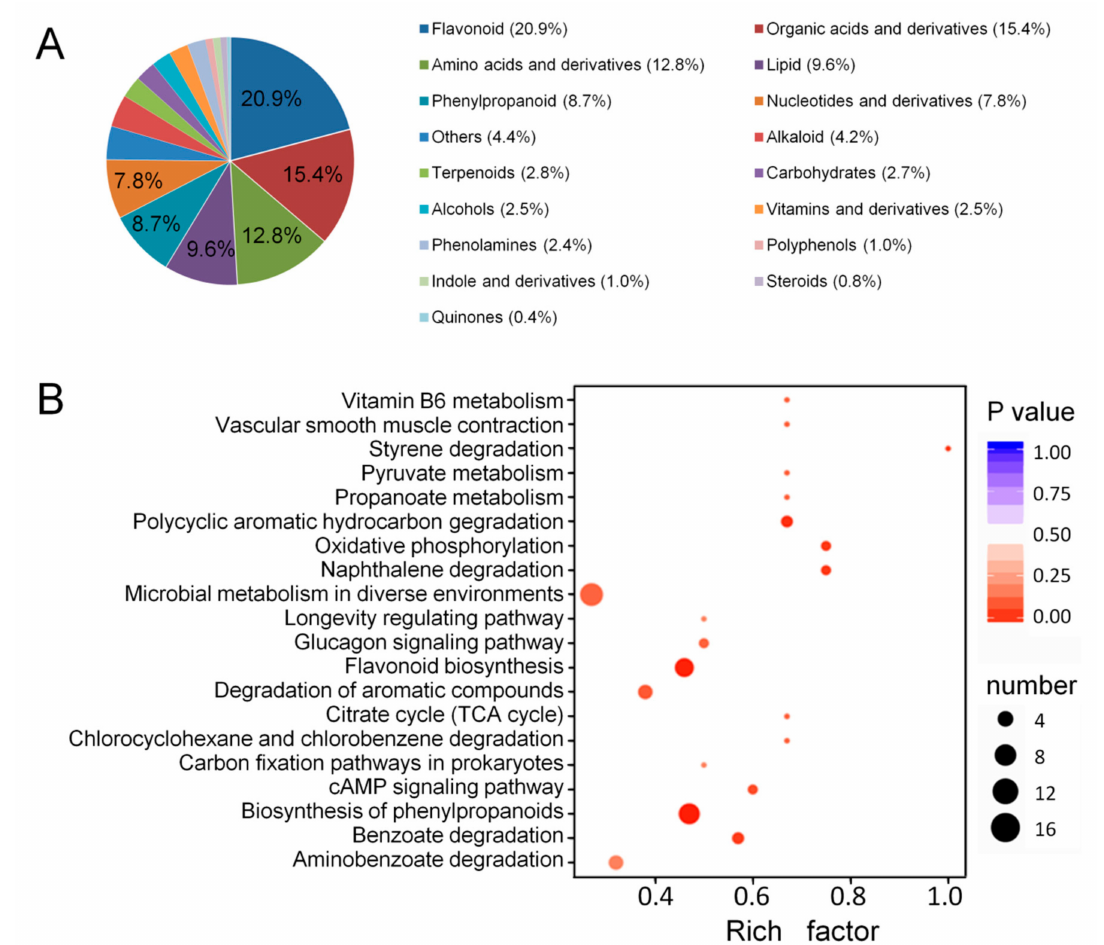
Figure 3. Component analysis of the putatively annotated metabolites and pathway enrichment analysis of the DAMs. ( A ) Component analysis of the putatively annotated metabolites from non- mycorrhizal A. roxburghii (NM) and mycorrhizal A. roxburghii (M) growth for six months. The percentage of the top six metabolites are shown in the graph. The percentage after each compound represents the percentage of the number of DAMs of a certain class of compounds in the total DAMs. ( B ) Pathway (top 20) enrichment analysis of the DAMs between the NM and M growth for six months. The x-axis represents the corresponding rich factor of each pathway. The y-axis represents the name of pathway. The color of the dot is p -value, and the closer it is to 0, the more significant the enrichment is. The size of the point represents the number of DAMs enriched in the corresponding pathway. The rich factor is the ratio of the number of metabolites in the corresponding pathway to the total number of metabolites detected and annotated in the pathway. The higher the value of rich factor is, the higher the enrichment degree